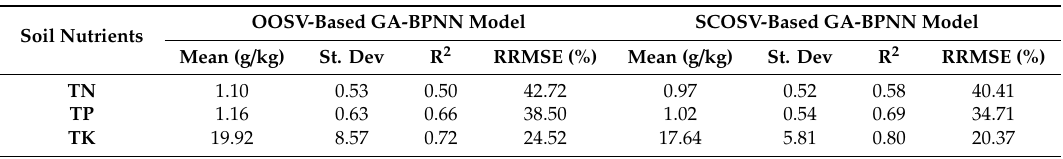
Table 4. Comparison of measured and predicted contents of TN, TP, and TK obtained using the original optimal spectral variables (OOSV) based GA-BPNN model and the soil component optimal spectral variables (SCOSV) based GA-BPNN model based on the 33 validation sample plots (St. Dev: